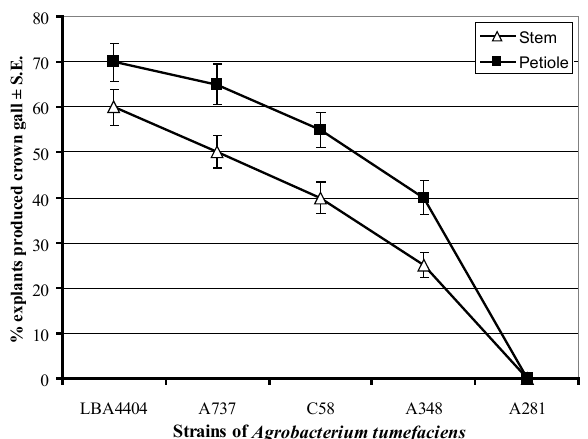
Fig. 1. Strain-dependent variation in crown gall induction on muskmelon explants at 39.3 μmol m -2 s